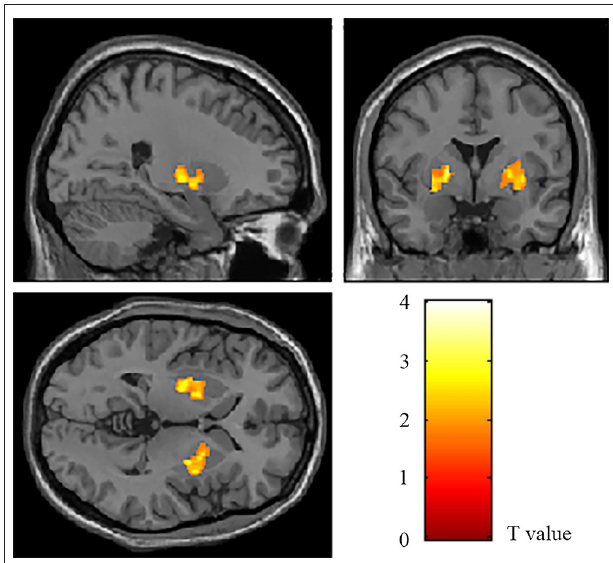
FIGURE 1 | The areas with a significant volumetric difference revealed by VBM analysis. The volume of bilateral lenticular nucleus (ROI L and ROI R ) increased in OCD patients compared to HCs ( p < 0.05, AlphaSim